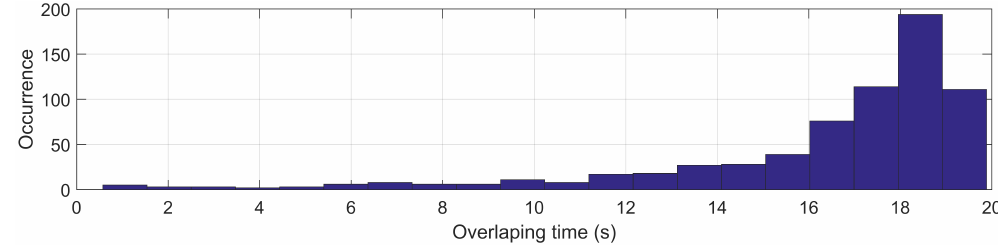
Figure 2. Histogram of the overlapping time of the step–stare measurements among the three lidars.